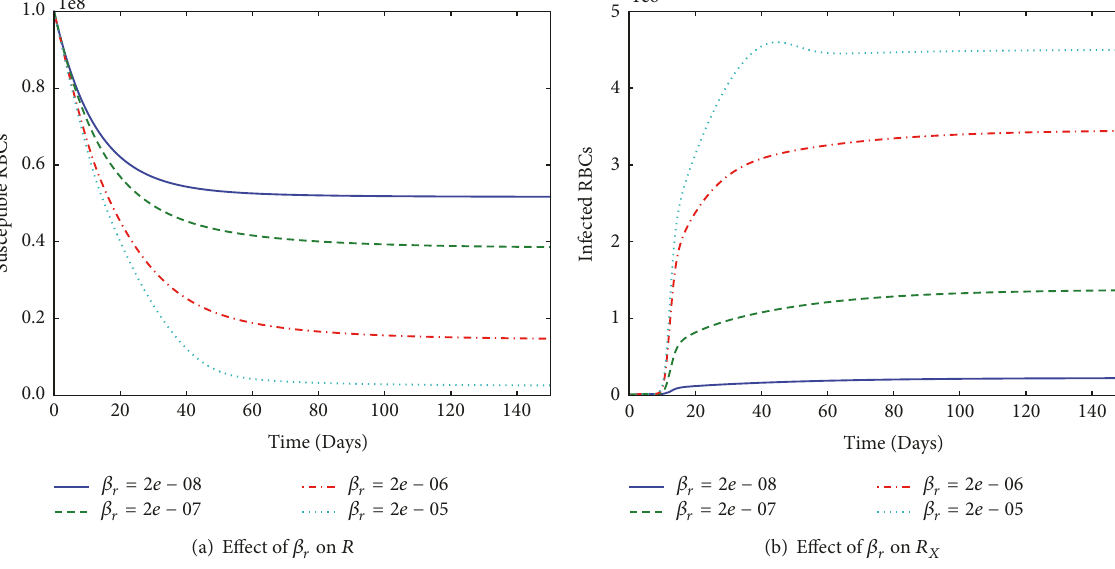
Figure7:Graphsshowingthebehaviourof(a)susceptibleRBCsand(b)infectedRBCs.Theywereobtainedbyvaryingthemerozoiteinvasion rate 𝛽 𝑟 from 2 × 10 −8 to 2 × 10 −5 in steps of 10 −1 , while keeping the other parameters in Table 3